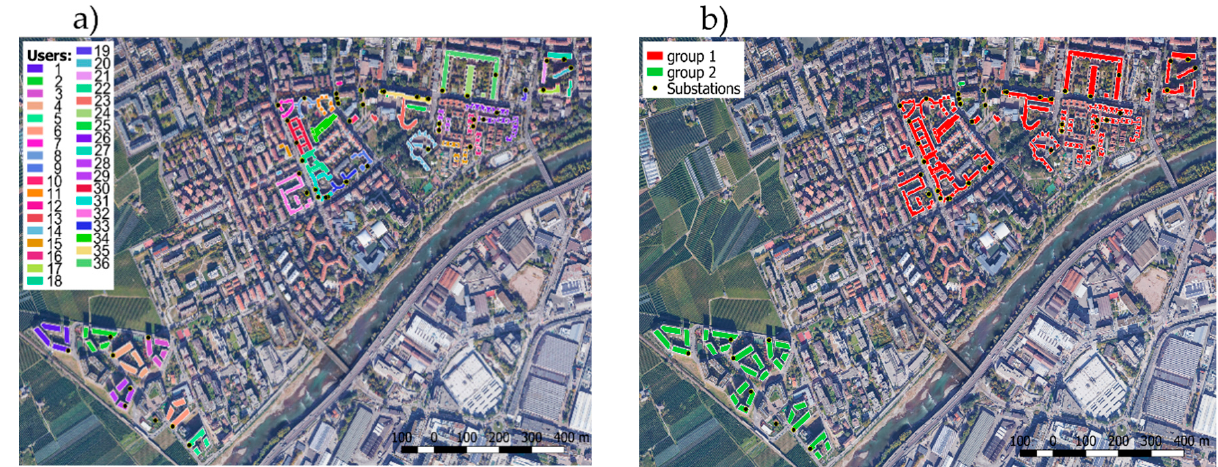
Figure 1. Map of the selected sample of residential users fed by the DH of Bozen-Bolzano in ( a ), and map of the load-based user groups in ( b ).